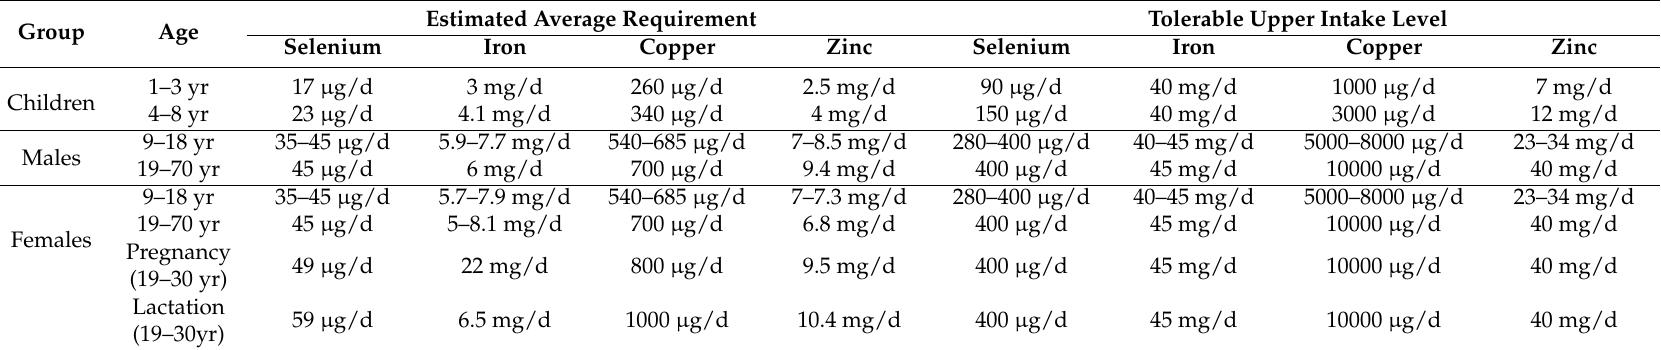
Table 3. Information regarding average dietary requirement and tolerable upper intake level of essential mineral ions in different age groups of humans.